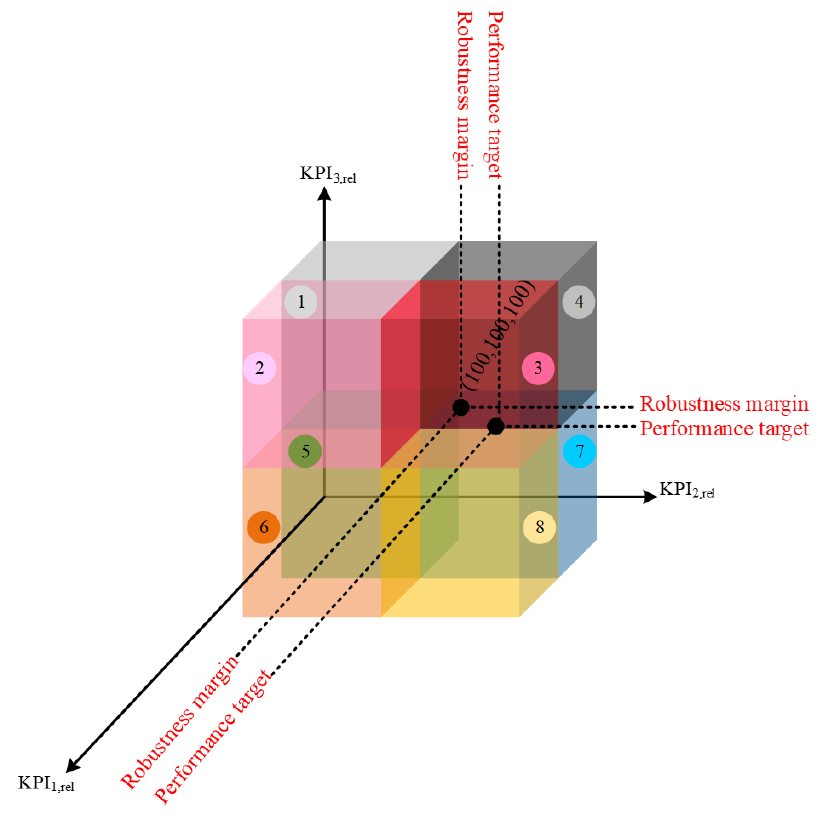
Figure 1. Illustration of performance zones for the MT-KPI.